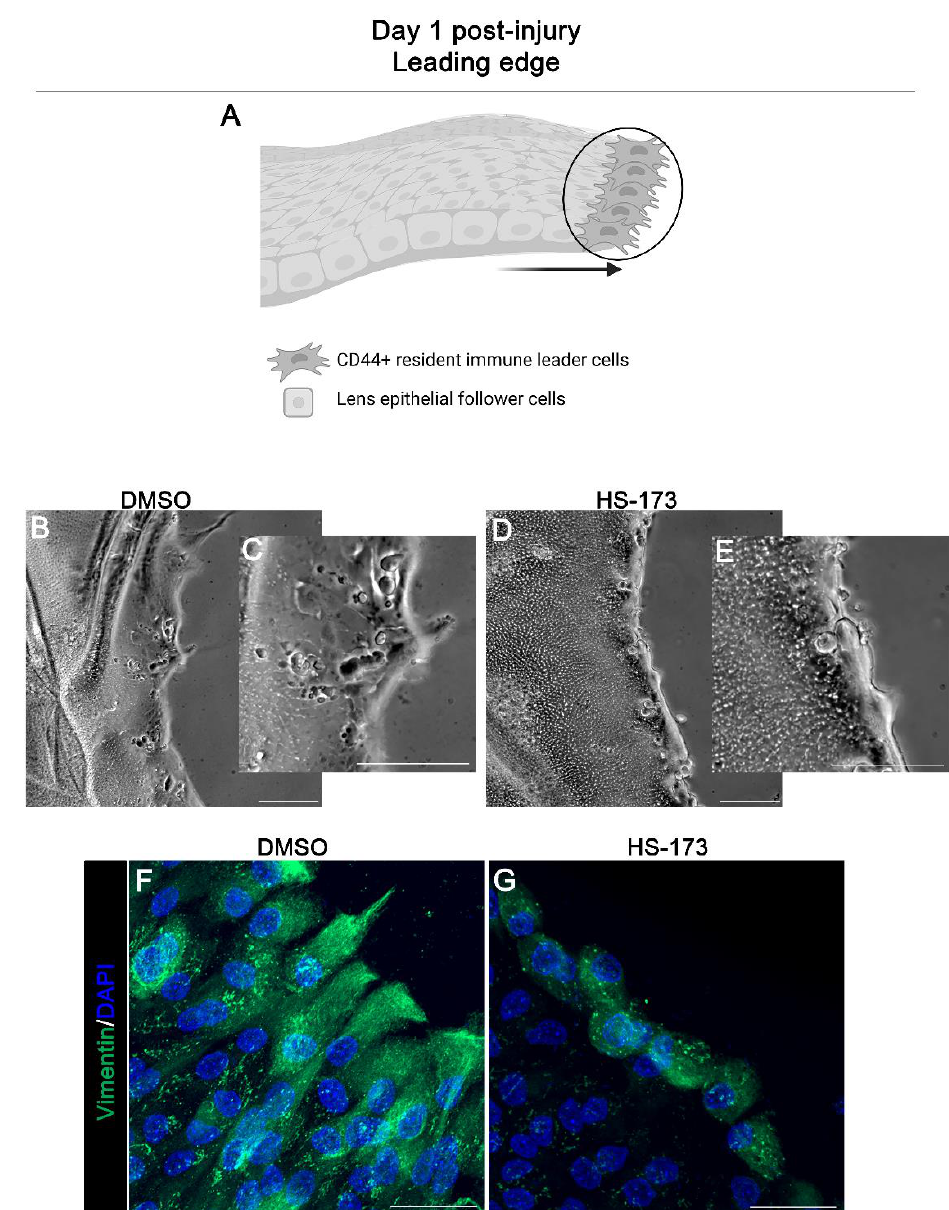
Figure 2. p110 α is required to initiate extension of vimentin rich lamellipodial of leader cells. ( A ) Model of CMZ highlighting our region of interest (leader cells, black circle) for these studies. ( B – G ) Ex vivo post-cataract surgery explants were treated with HS-173 to inhibit p110α from Time 0 for 24 h (Day 1 post-injury). ( B ) Phase contrast imaging shows that in the presence of DMSO leader cells extend protrusions at the wound edge. ( D ) In contrast, HS-173 blocked leader cell protrusion at the wound edge. Regions in ( B , D ) are shown at higher magnification ( C , E ). ( F , G ) Cataract surgery explants day 1 post-treatment were immunolabeled for vimentin (green) and counterstained for DAPI (blue). Confocal images revealed vimentin-rich lamellipodia extensions at the leading edge were blocked by HS-173 treatment ( G ) compared to vehicle control ( F ). Magnification bars = 50 μ m ( B – E ) and 20 μ m ( F , G ).